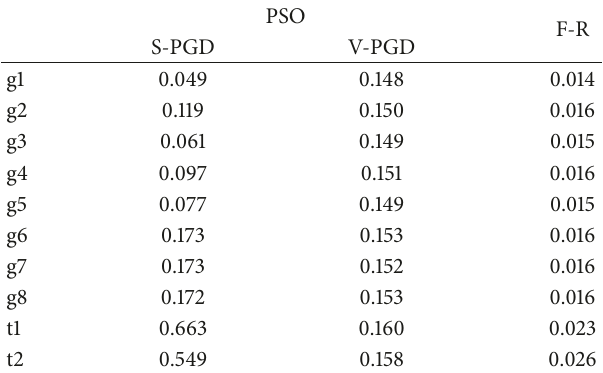
Table 1: Running time (s) of the three methods on 10 graphs.